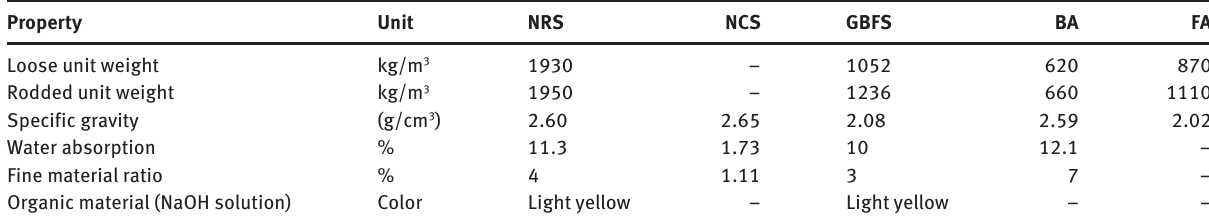
Table 5: Properties of aggregates used.